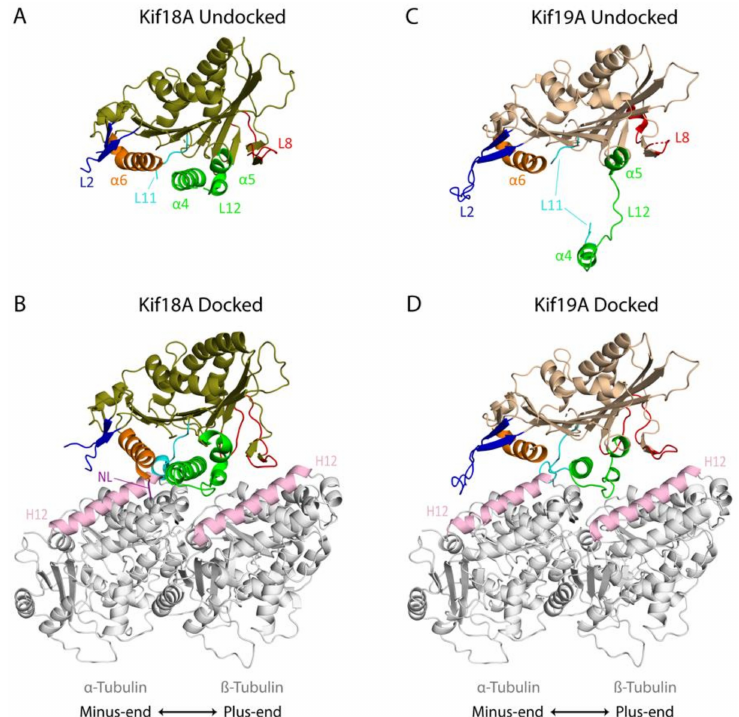
Figure 2. Crystal structures of Kinesin-8 proteins and their cryo-EM MT docked state: ( A ) Undocked Kif18A complexed with Mg 2+ -ADP (PDB: 3LRE) [82]. ( B ) Nucleotide free Kif18A docked to the MT (PDB: 5OAM) [77]. ( C ) Undocked Kif19A complexed with Mg 2+ -ADP (PDB: 5GSZ) [79]. ( D ) Nucleotide free Kif19A docked to the MT (PDB: 5GSY; tubulin coordinates provided by N. Hirokawa)